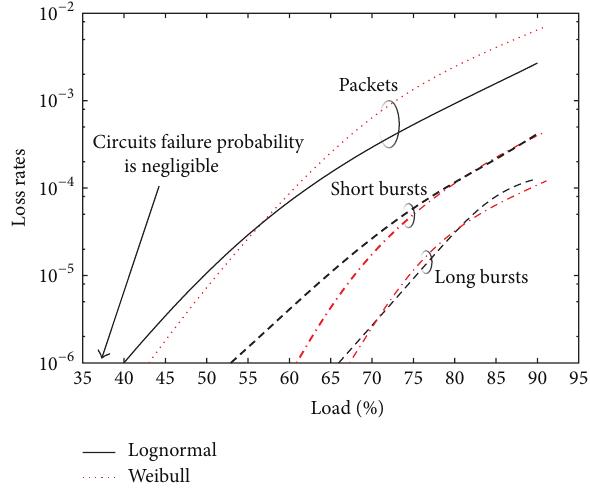
Figure4:AveragedatalossratesintheHOSnetworkasafunctionof the input load. Two different traffic distributions, that is, lognormal and Weibull, are considered.